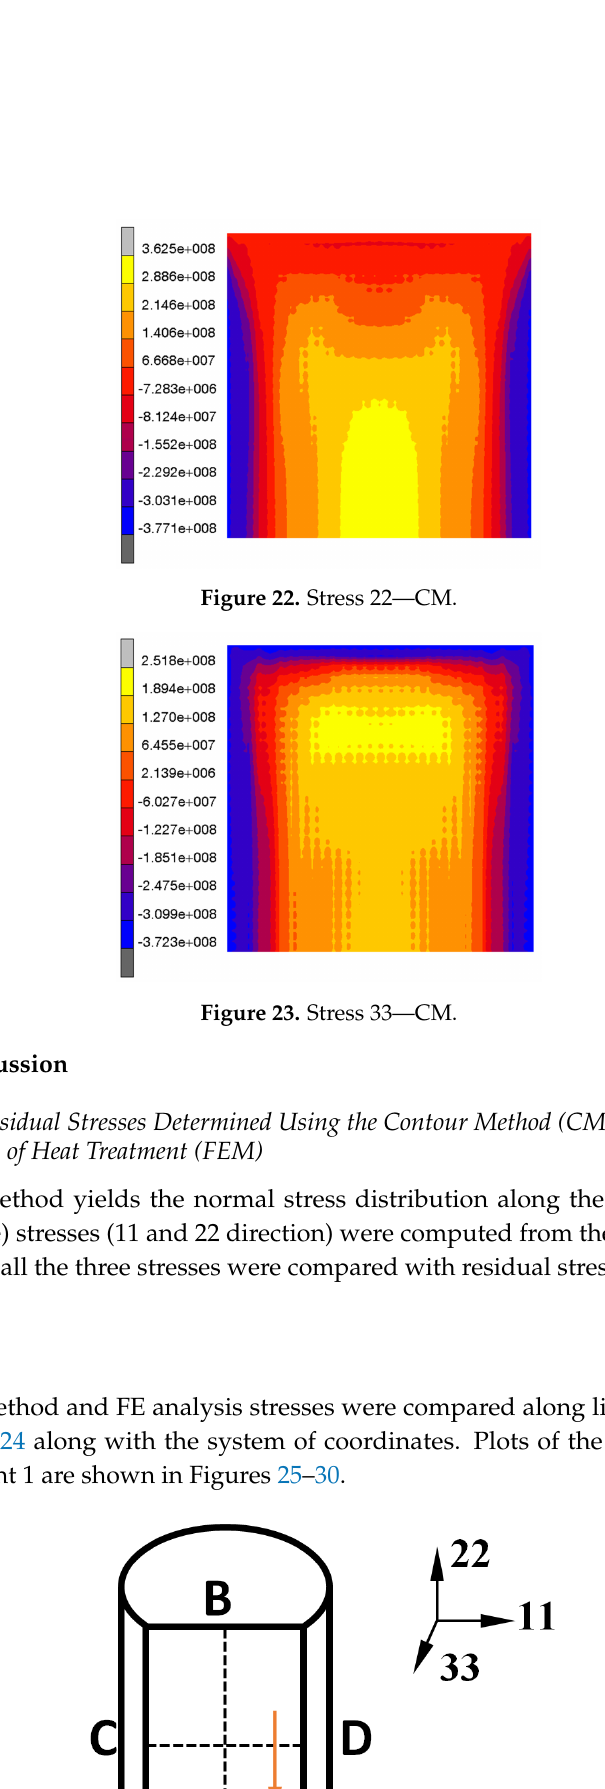
Figure 22. Stress 22—CM.